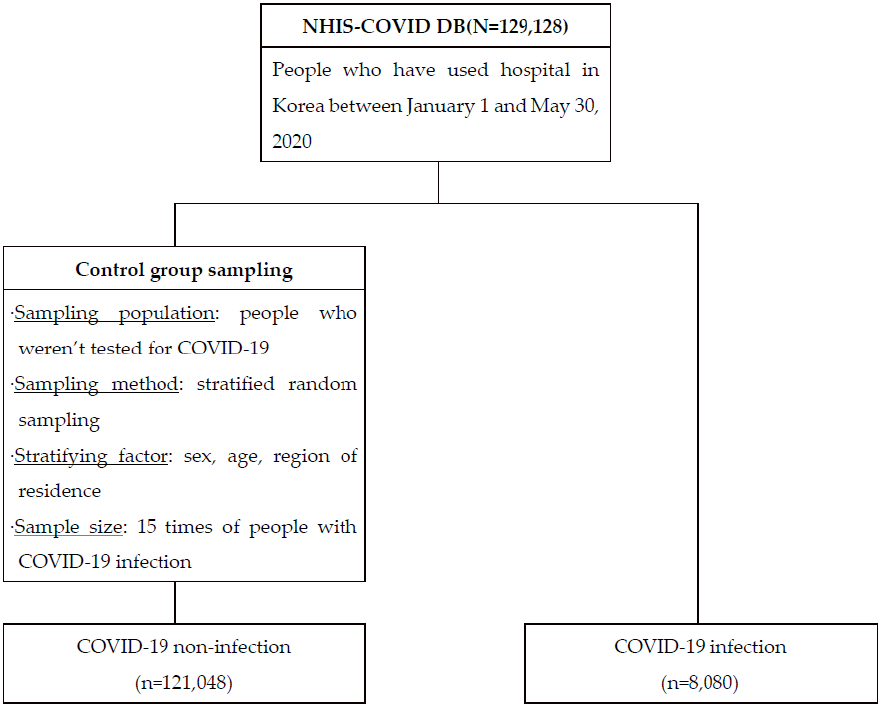
Figure 1. Flow chart for people included in the analysis .